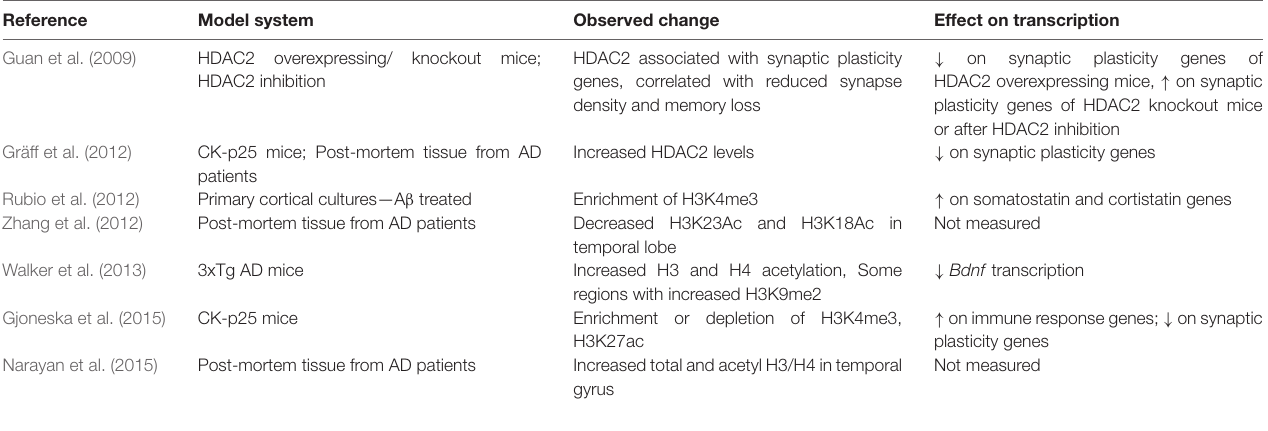
TABLE 1 | Epigenetic histone modifications observed in Alzheimer’s disease